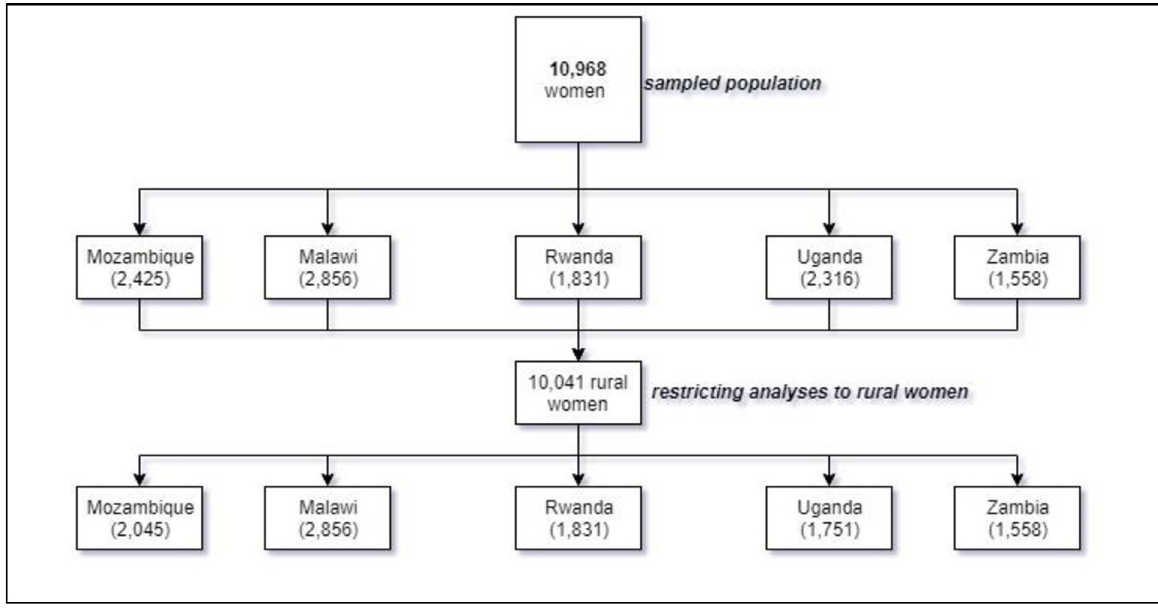
Fig 1. Breakdown of FTF